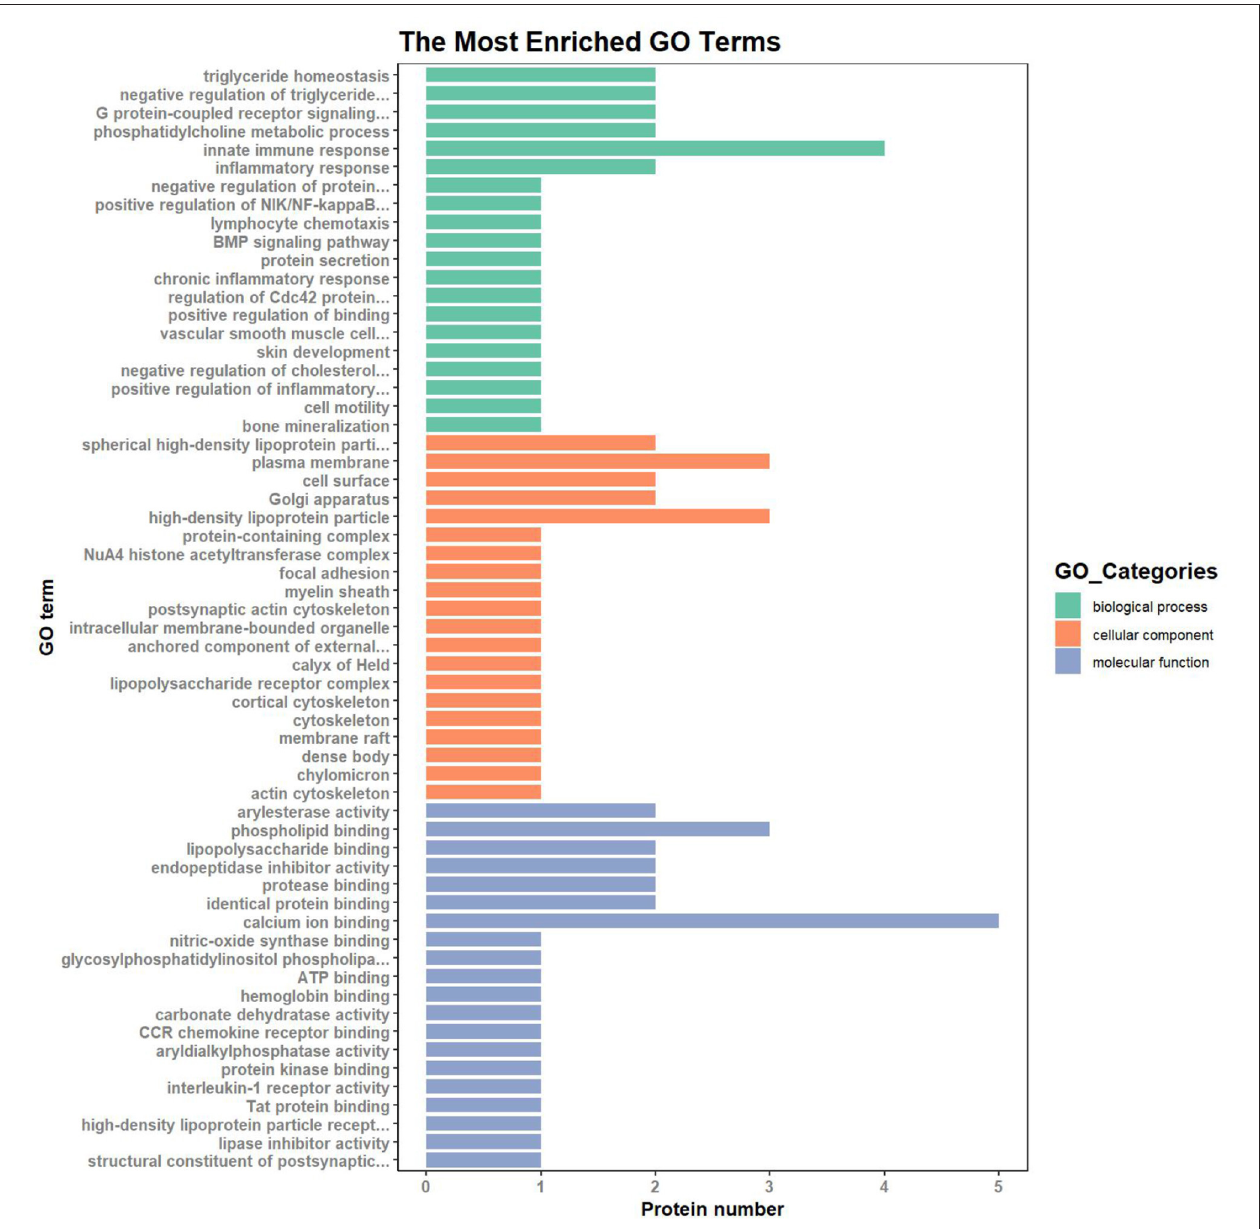
FIGURE 5 | GO (Gene Ontology) analysis of subclinical VE deficiency-related proteins. Green represents biological process, orange represents cellular process, and blue represents molecular process. Classification of 26 DEPs based on biological process, molecular function, and subcellular localization. The abscissa represents the number of differential proteins in each functional category. Based on BP, these subclinical VE deficiency-related proteins were mainly involved in innate immune response and triglyceride homeostasis. The higher enrichment of CC was the plasma membrane and high-density lipoprotein particle, and the functions of higher MF enrichment were calcium ion binding and phospholipid